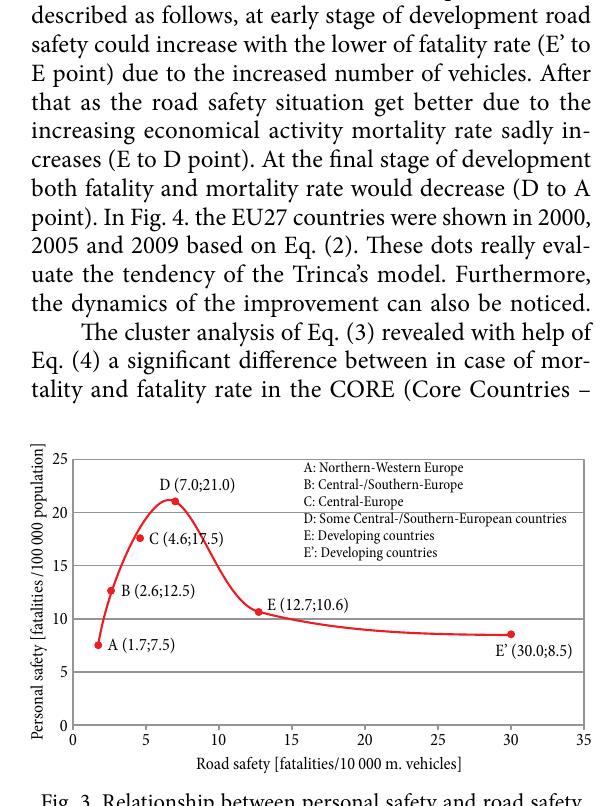
Fig. 3. Relationship between personal safety and road safety (theoretical model) (source: Trinca et al. 1988)